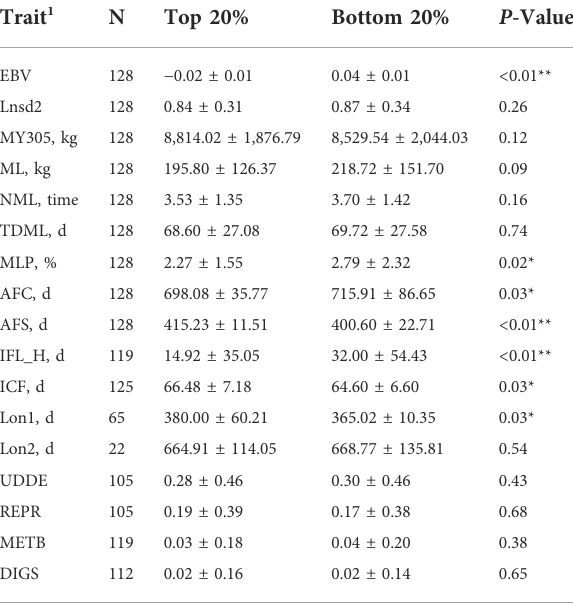
TABLE 6 Comparison of top 20% and bottom 20% estimated breeding values (EBVs) in the validation dataset of